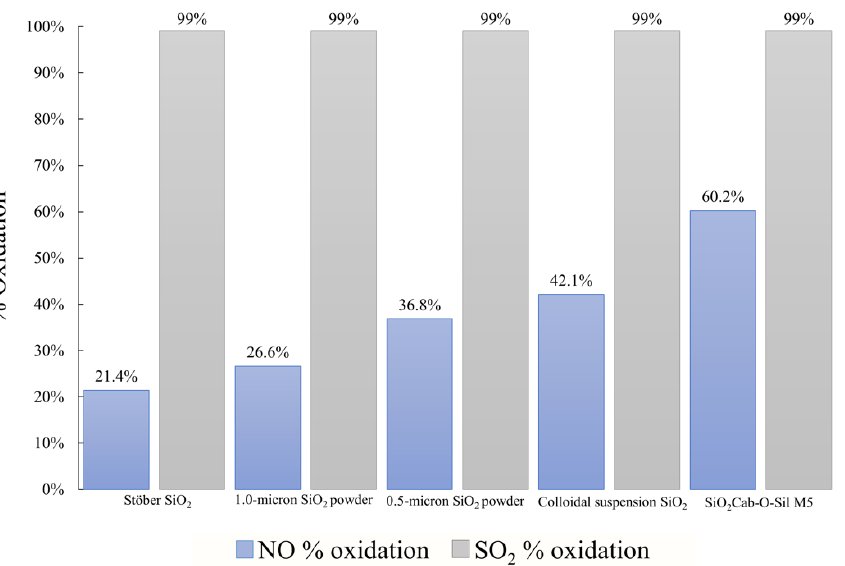
Figure 1. Percent NO and SO 2 oxidation on different SiO 2 nanocarriers (all the catalysts are Co oxide impregnated on silica (SiO 2 /Co(OH) 2 ) homogeneously dispersed in aqueous solution); [SiO 2 ] = 1 wt%, [Co] = 6